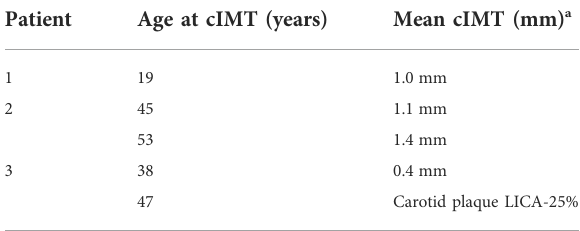
TABLE2Imagingcharacteristicsofthepatients-Carotidintima-media thickness measurements and carotid Doppler tests.